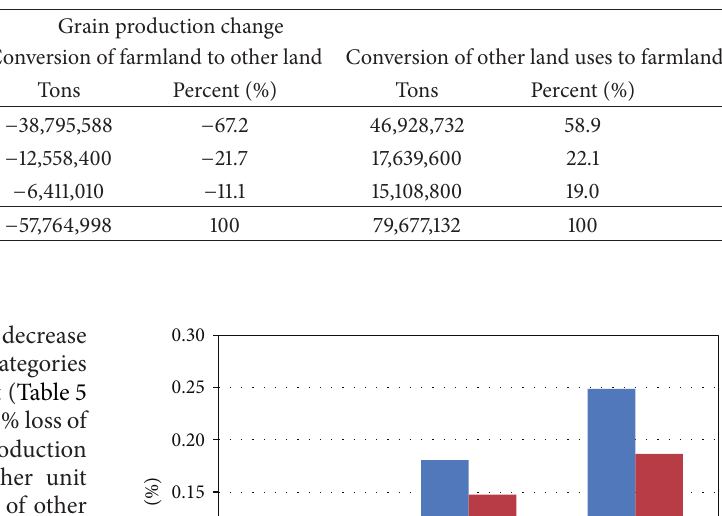
Table 5: Grain production changes from farmland conversion from the late 1980s to 2008.